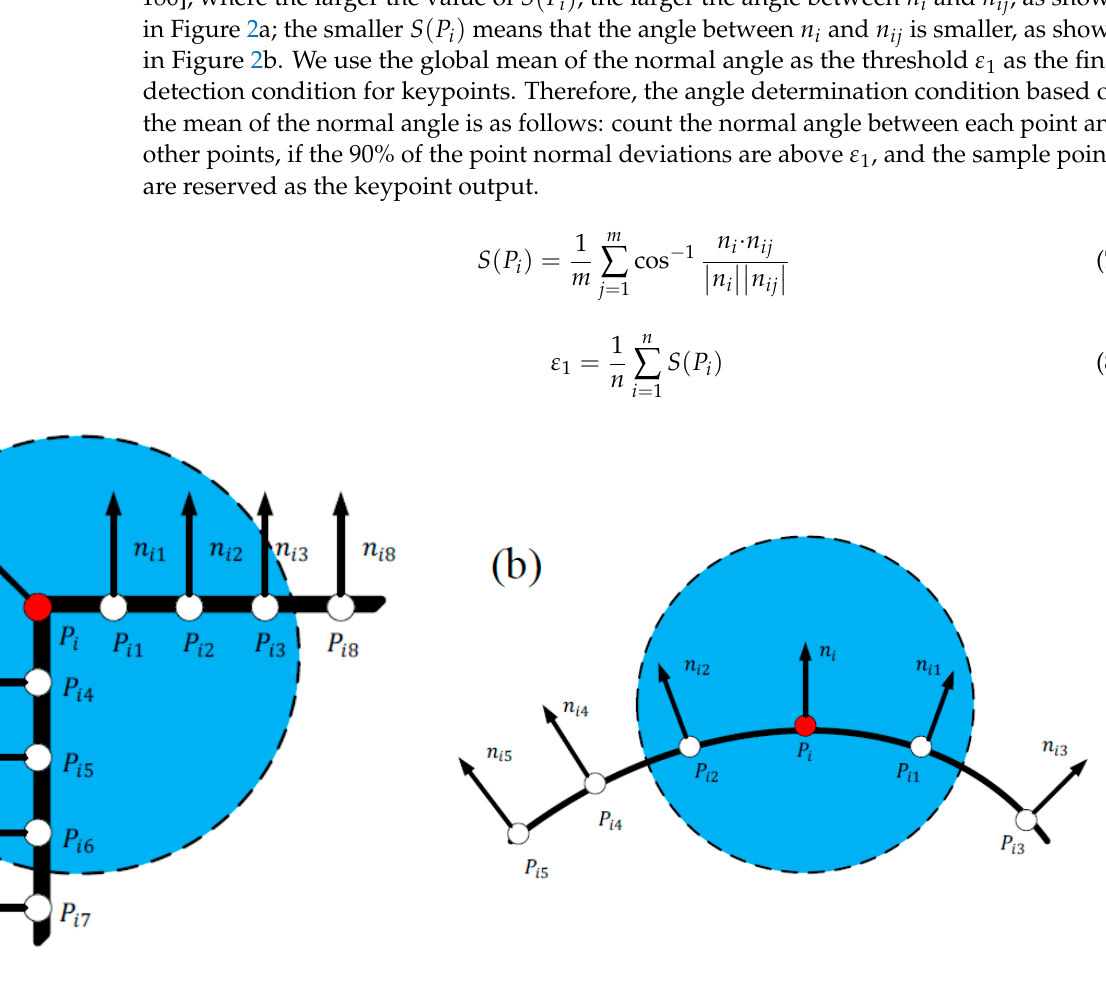
Figure 2. Shown from different angles. ( a ) corner point; ( b ) surface point.